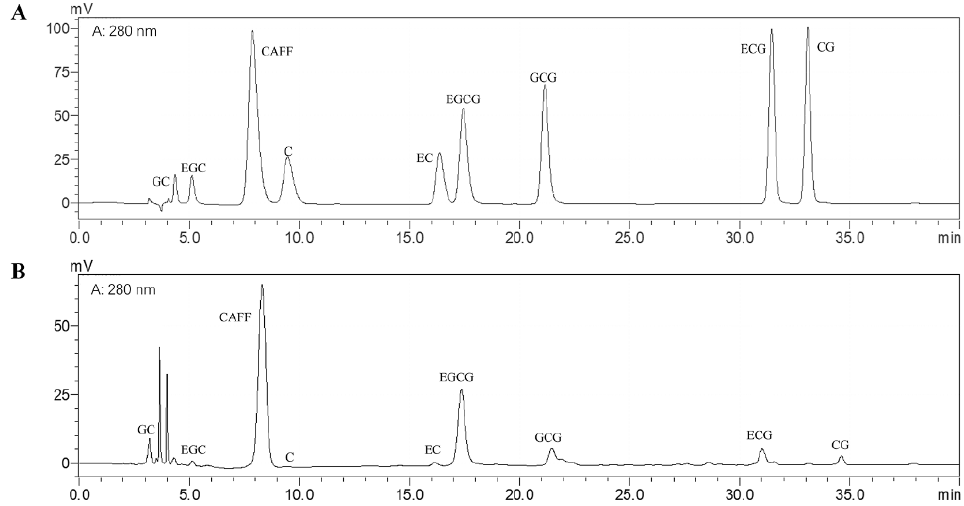
Figure 1. The UPLC chromatograms of catechin monomers and caffeine in the matcha sample. ( A ) Standard mixture; ( B ) matcha sample.